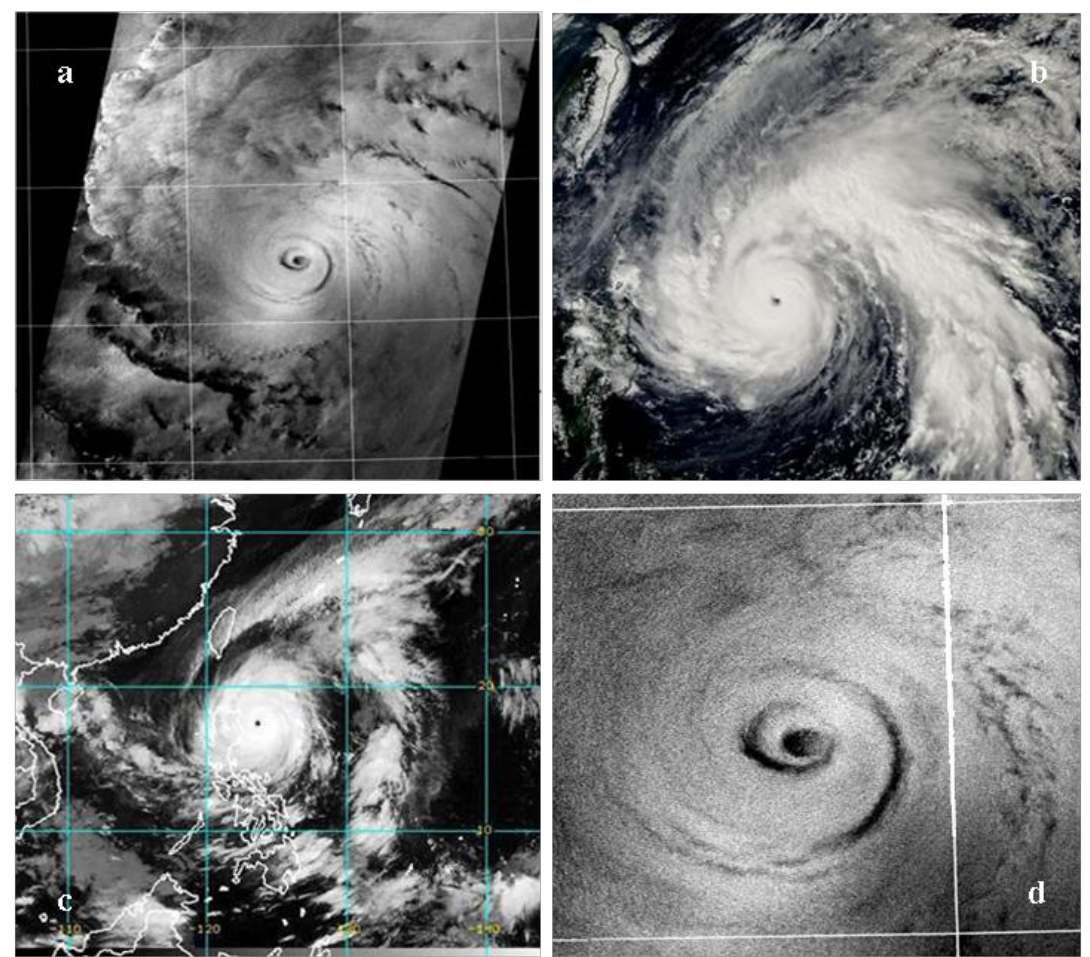
Figure 2. Satellite images of Typhoon Megi collected over the southeast of Taiwan on 17 October 2010 from ( a ) Envisat; ( b ) MODIS; and ( c ) MTSAT, respectively. The typhoon eye as a dark circle can be easily detected in ( d ) the zoom-in Envisat SAR subscene.